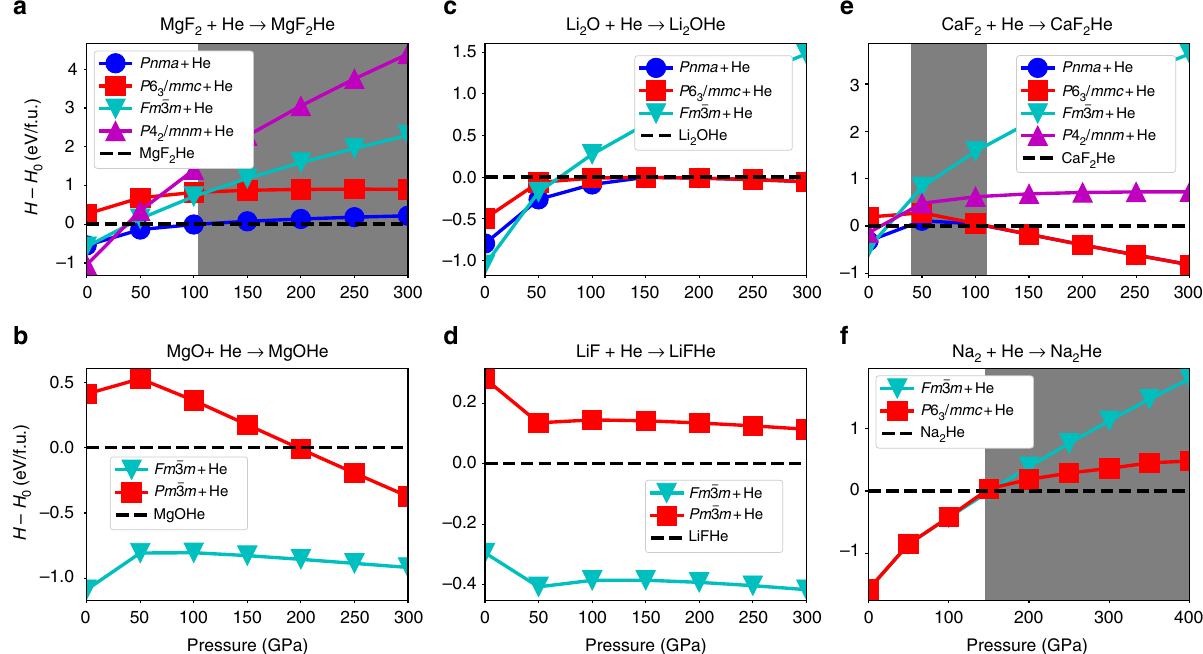
Fig. 1 The enthalpy difference between A-B + He and A-BHe. Calculations, between helium and a MgF 2 , b MgO, c LiF, d Li 2 O, e CaF 2 , and f Na, are plotted as a function of pressure. The pressure range in a – e is 0 – 300 GPa, and in f is 0 – 400GPa. The dashed lines refer to the enthalpy of the He-inserted compounds. When a solid line is above the dashed line, the corresponding structure of the ionic compound is unstable relative to the He-inserted compound. Shaded areas present the pressure intervals of stable He